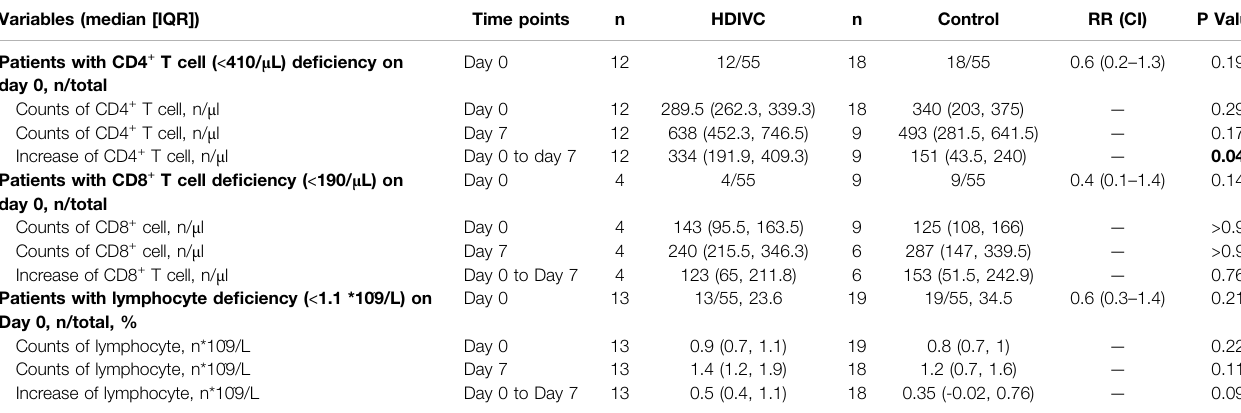
TABLE 3 | Effect of HDIVC on the recovery of immune function de fi